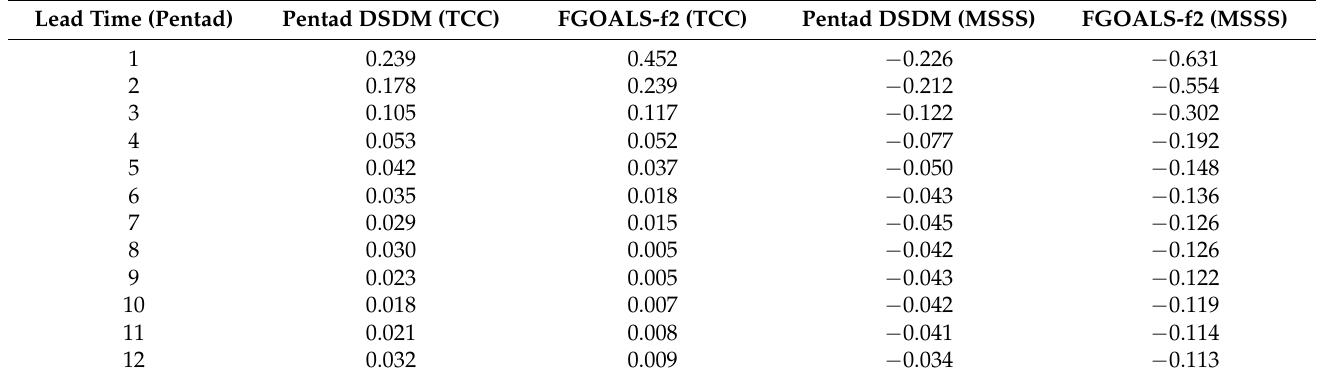
Table 1. Skill scores averaged over the whole of mainland China.